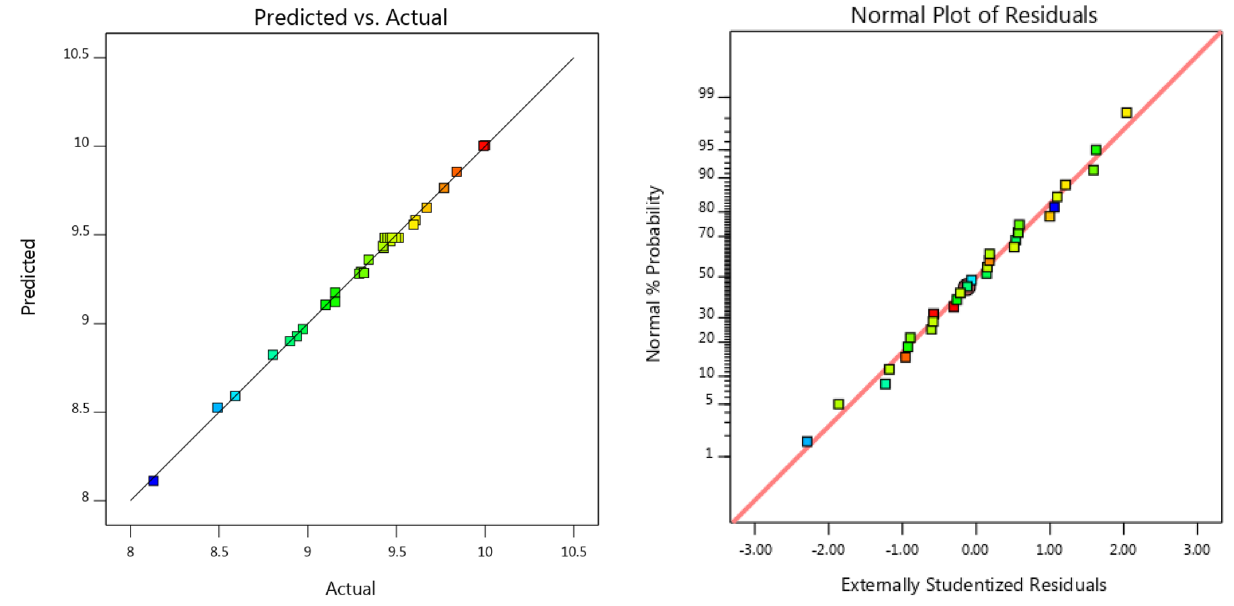
Figure 11. ( a ) The relationship of predicted and actual values of the RSM model for naproxen removal; ( b ) the externally studentized residuals versus normal % probability